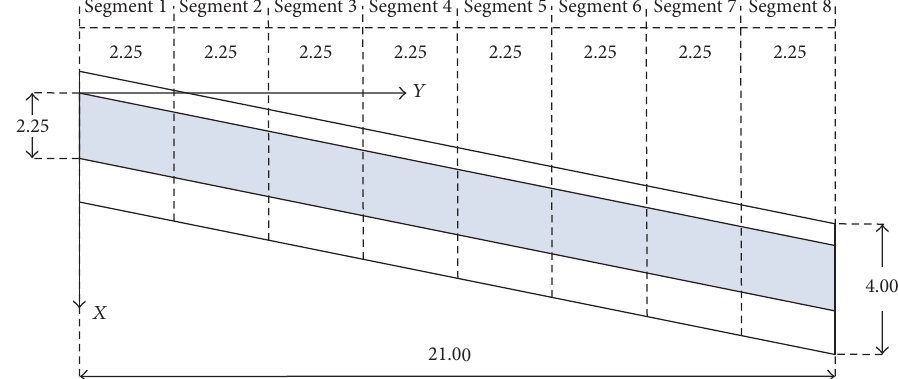
Figure 4: Planform of composite outer wing modeled in eight single-cell wing-box beams.